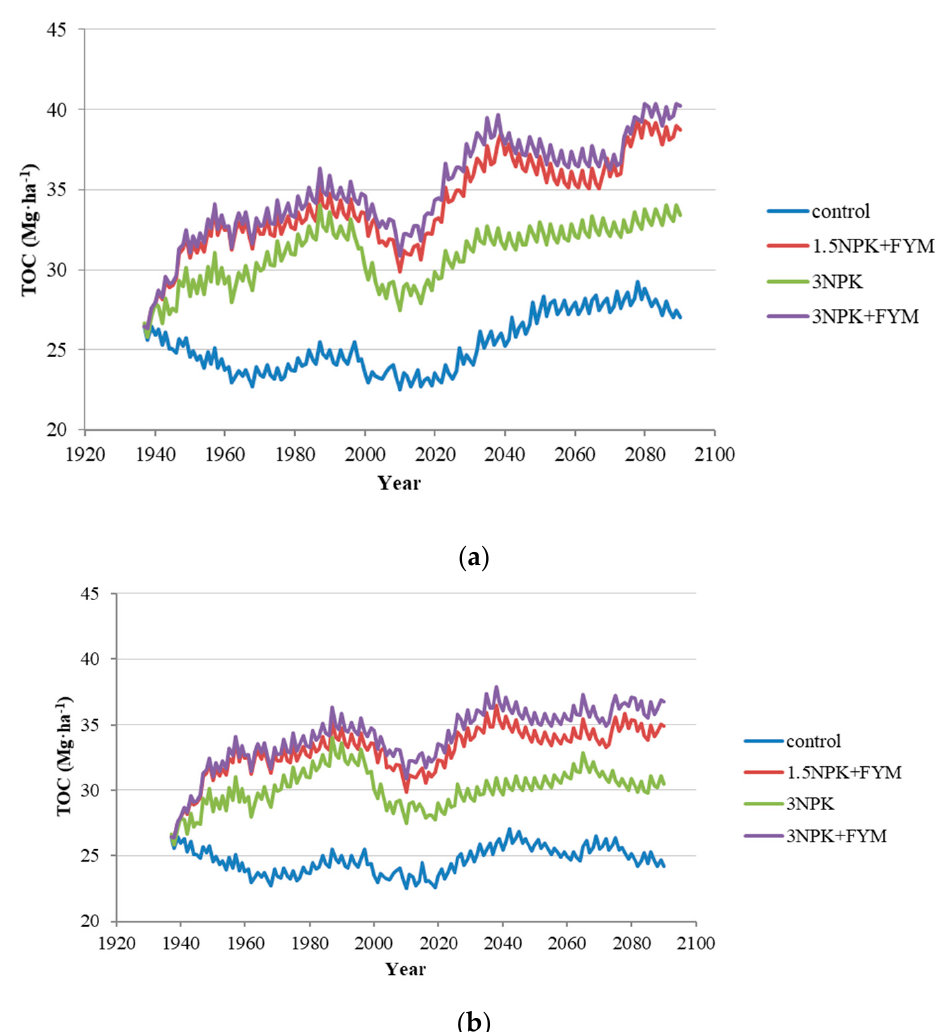
Figure 2. Simulated annual dynamics of total organic carbon (TOC) stocks in the DAOS 3 experiment (1937–2090): ( а ) RCP4.5 and ( b ) RCP8.5. DAOS: Dolgoprudny Agrochemical Experimental Station and FYM: farmyard manure. Table 2. Annual gain/loss and input of C by treatments. RCP: Representative Concentration Path- ways.